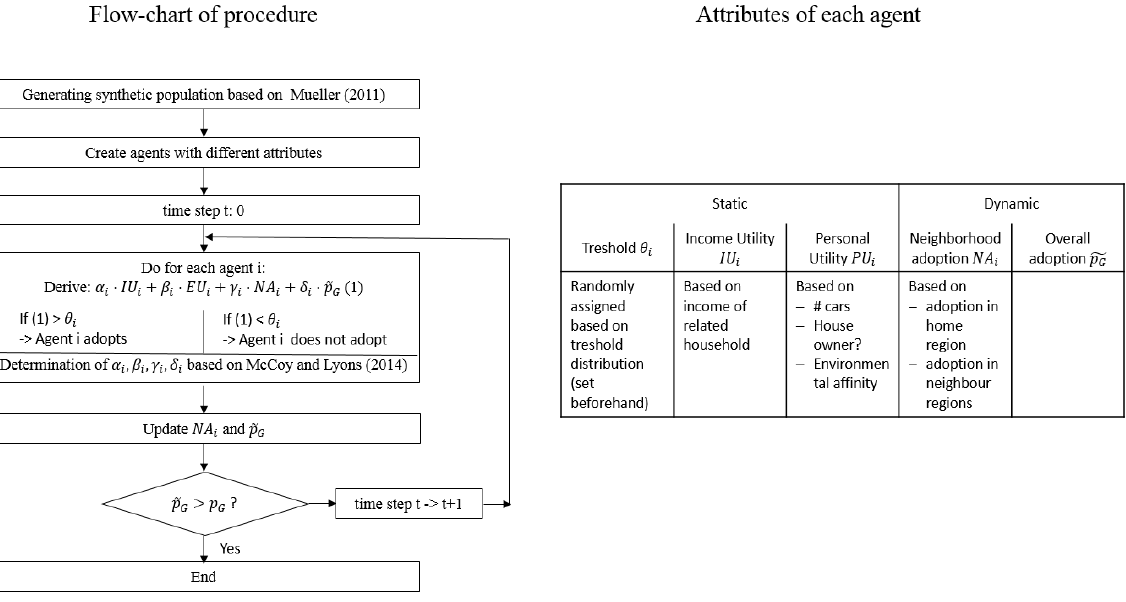
Figure 2. (a) Flow chart of simulation of agent-based BEV adoption; (b) Influencing factors on BEV adoption process for each